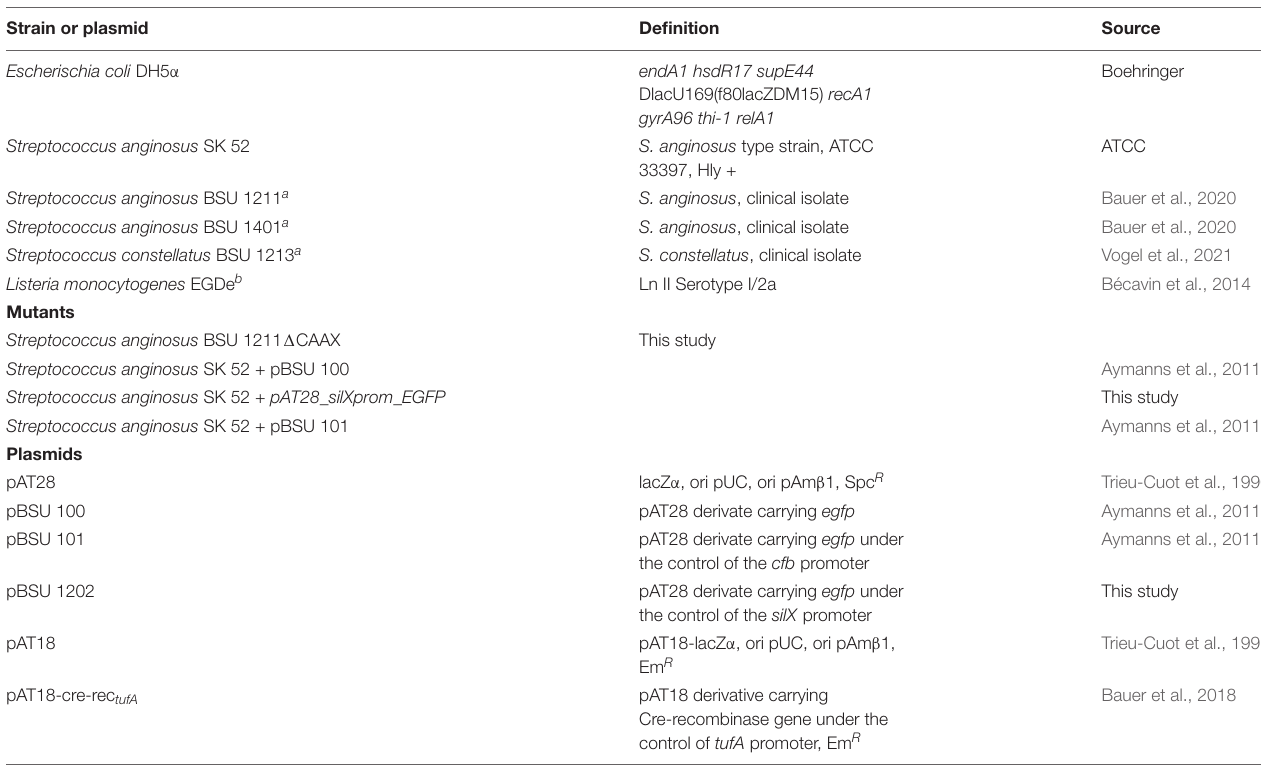
TABLE 1 | Strains and plasmids used in this